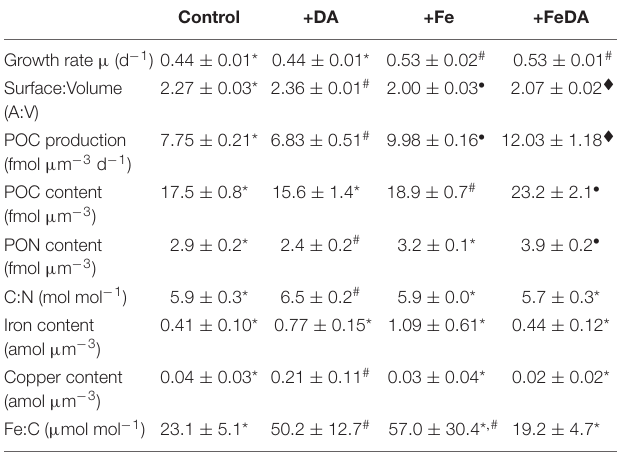
TABLE 3 | Growth rates, surface to volume quotients (A:V) and particulate organic carbon (POC) production rates and elemental composition of the cells: cell-volume-normalized particulate organic carbon and nitrogen (POC, PON) contents, molar carbon to nitrogen ratios (C:N), cell-volume-normalized iron and copper contents and molar iron to carbon (Fe:C) ratios for the four different